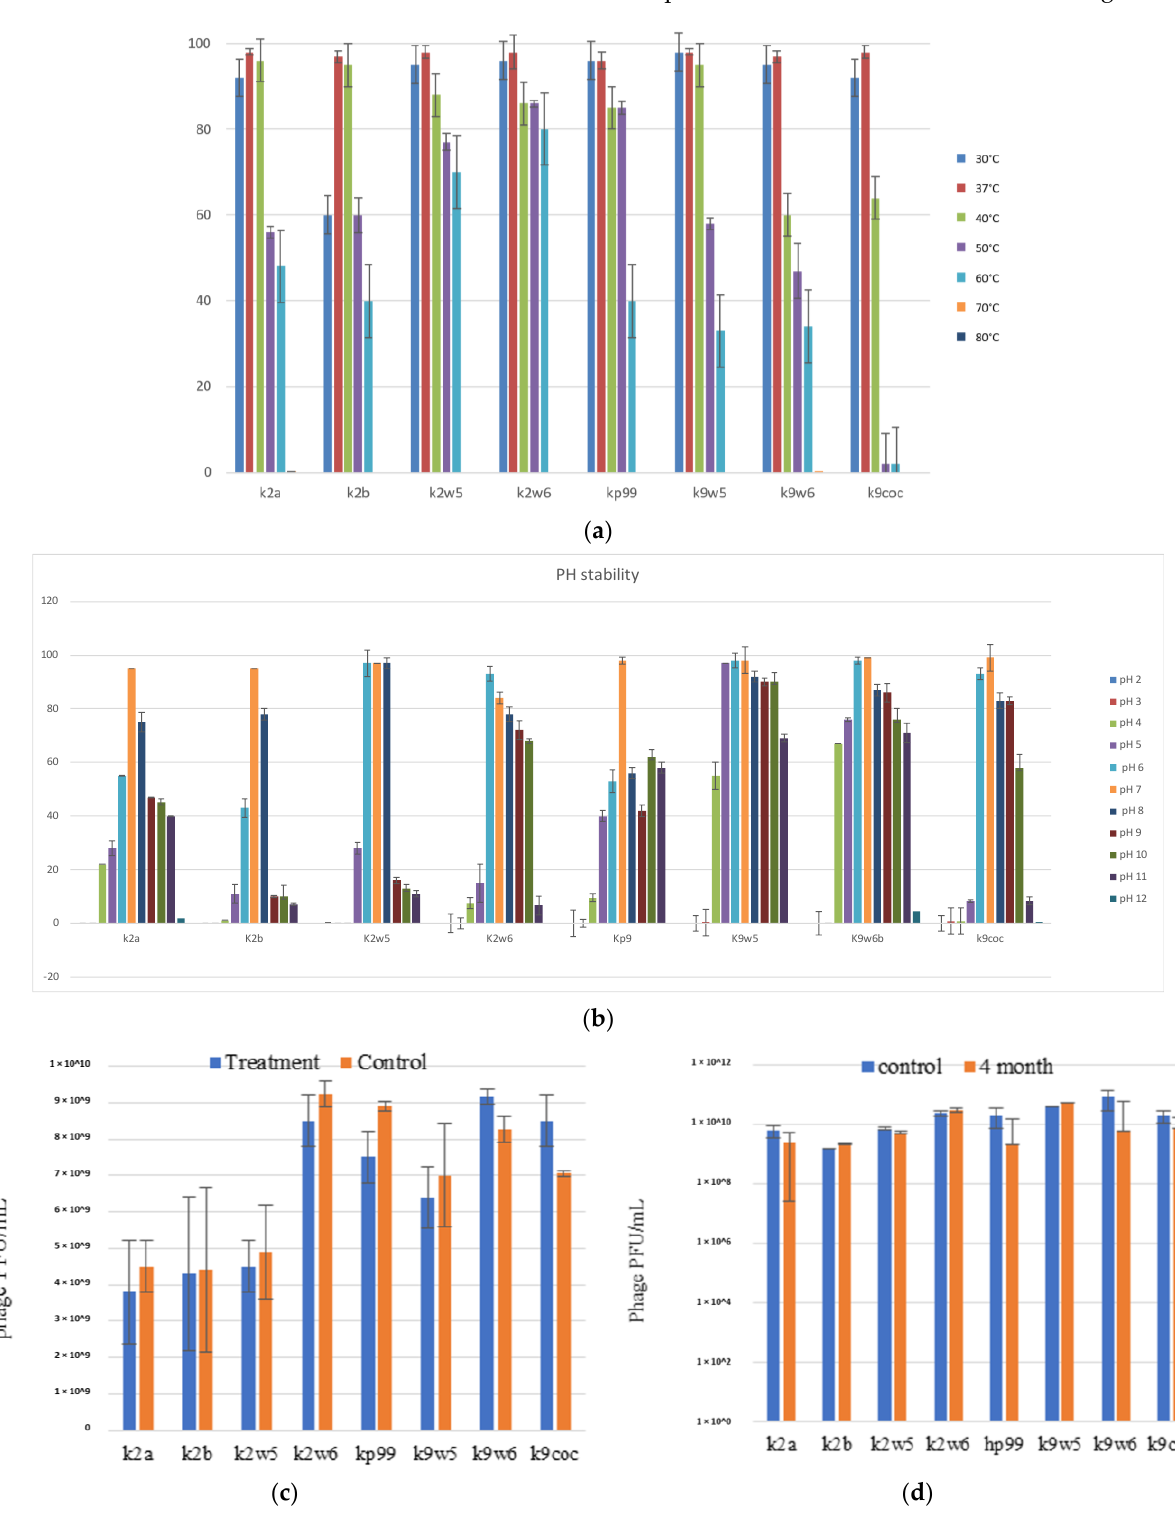
Figure 4. The stability of bacteriophages at different temperature, pH, chloroform, and long-term storage. ( a ) The fffect of variable temperatures on bacteriophage activities; ( b ) The effect of different pH on bacteriophage activities; ( c ) The effect of chloroform on the bacteriophage; ( d ) The effect of long-term cold storage on bacteriophage activities. All values represent the mean of three replicates ± SD.